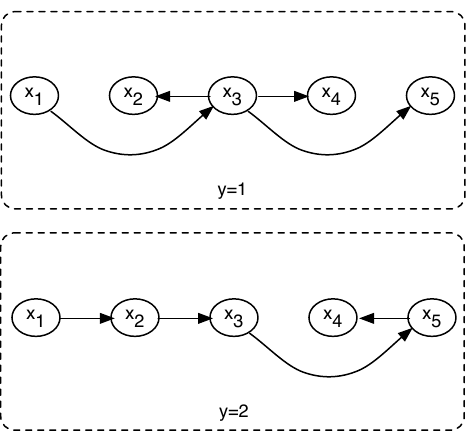
Figure 3. Example of the Chow–Liu tree